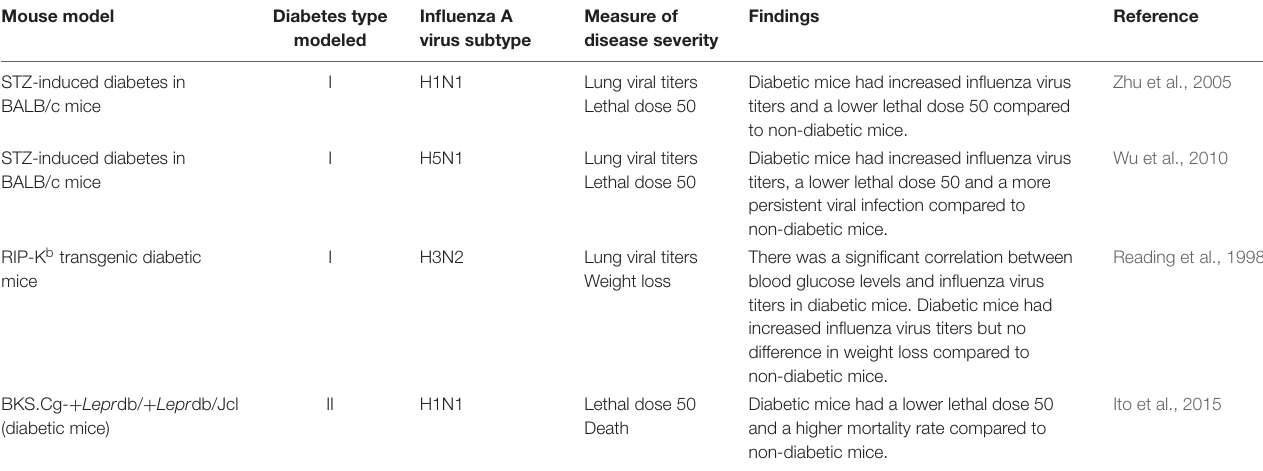
TABLE 2 | Animal models of diabetes and